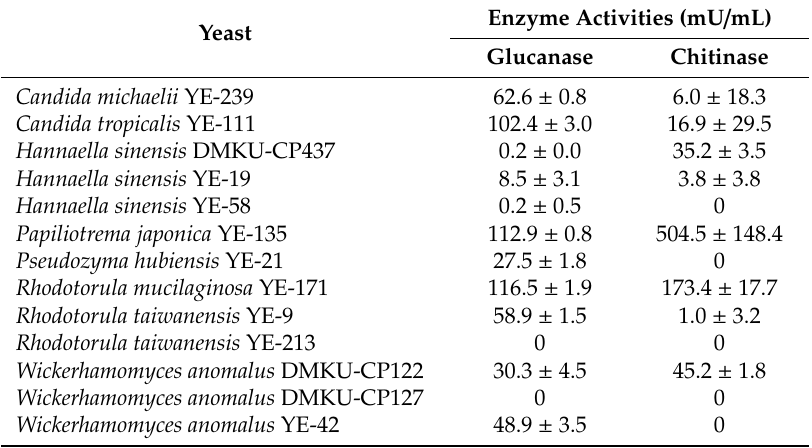
Table 2. Activities of cell wall lytic enzymes produced by antagonistic